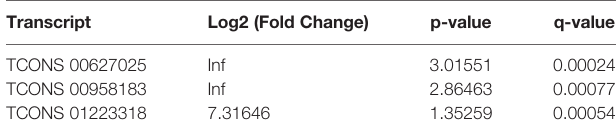
TABLE 4 | Differential analysis of new lncRNA